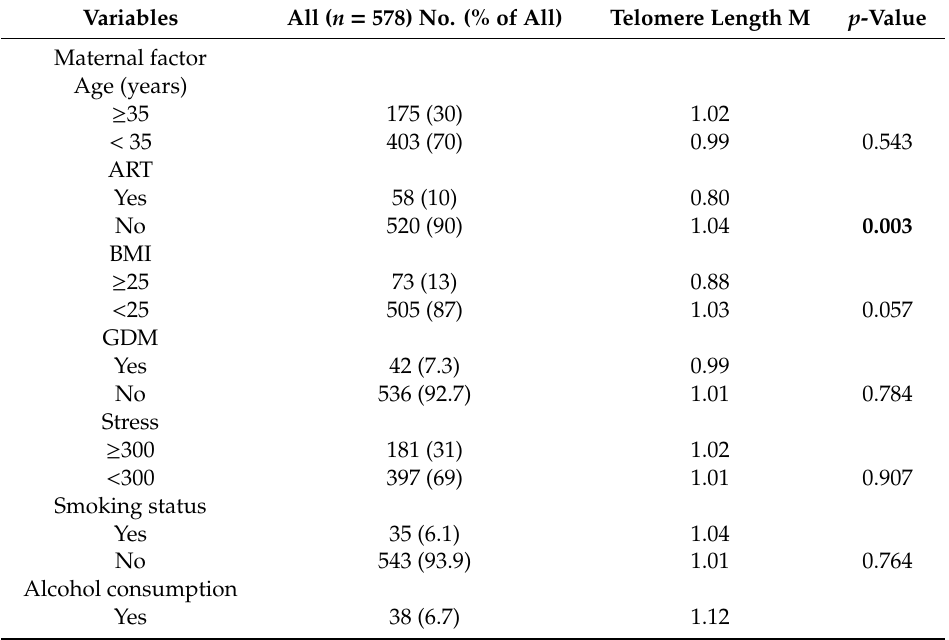
Table 2. Correlation between telomere length and each perinatal